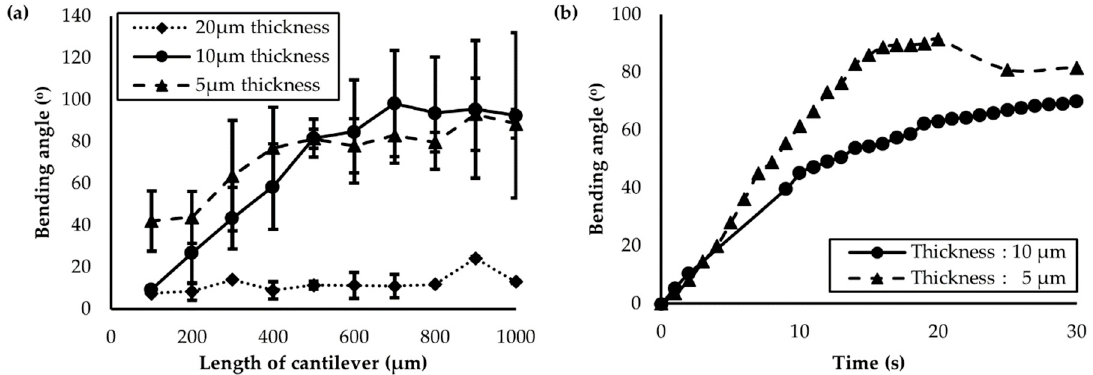
Figure 5. ( a ) Maximum bending angle as a function of actuator length and thickness; ( b ) change in the bending angle with respect to the ultraviolet exposure time. Actuators with thicknesses of 10 µ m and 5 µ m (solid and dashed lines, respectively) were compared.